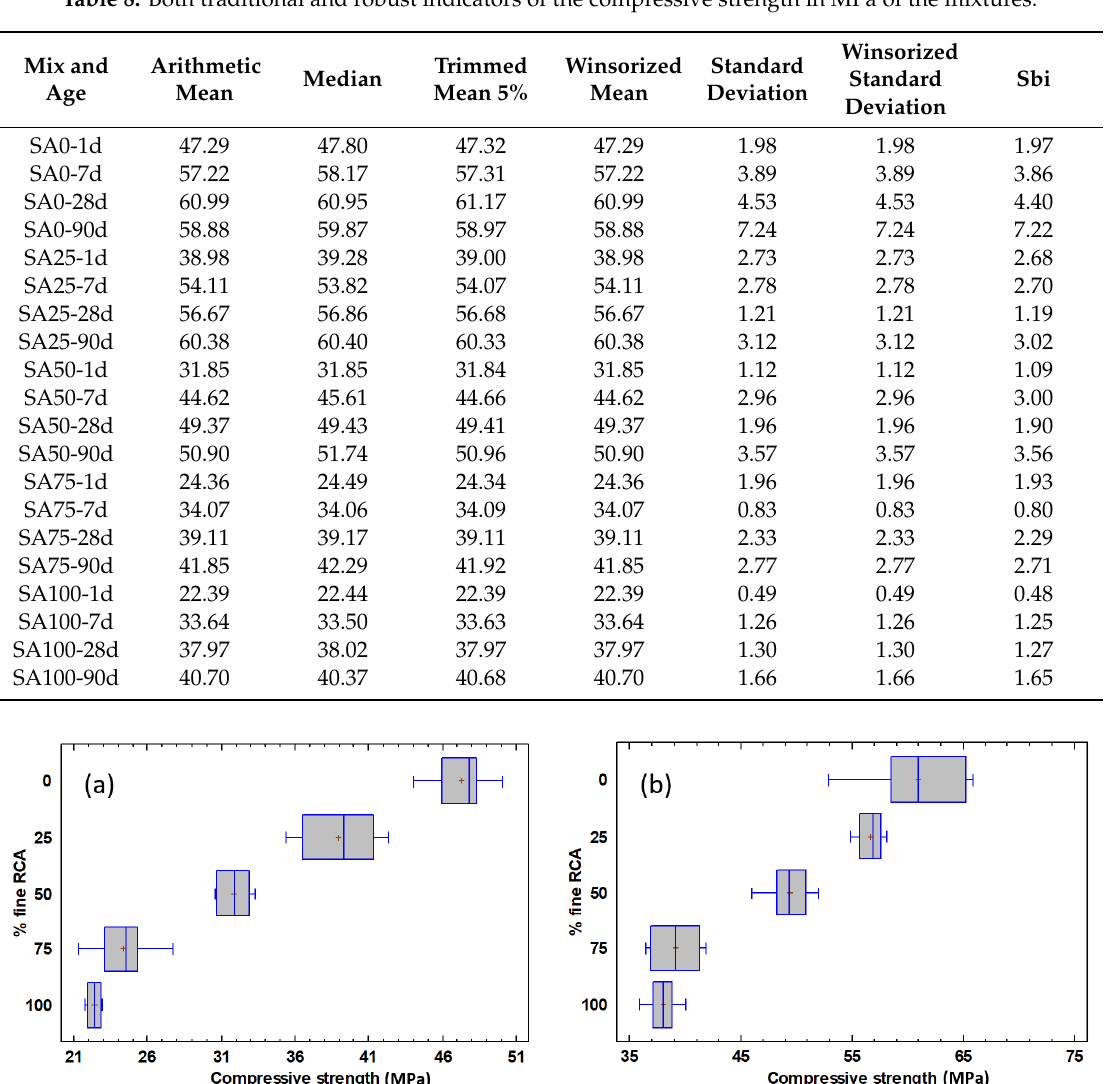
Figure 3. Box plot for all mixes: ( a ) 1 day; ( b ) 28 days.